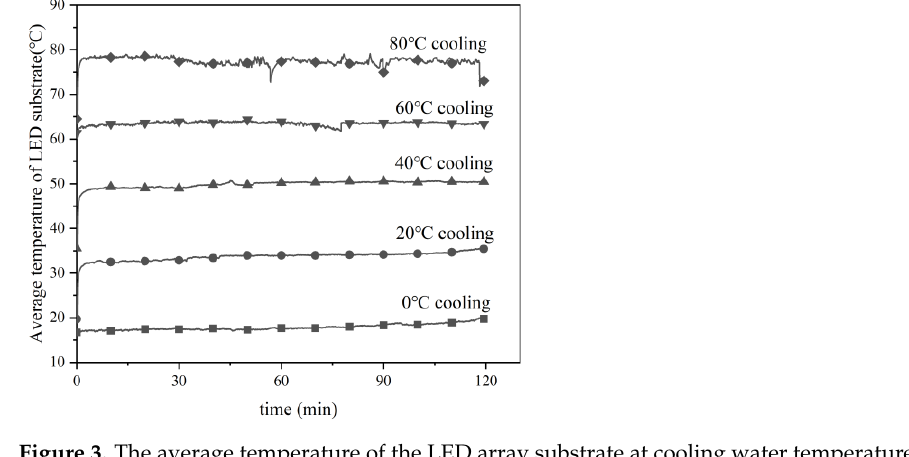
Figure 3. The average temperature of the LED array substrate at cooling water temperatures of 0, 20, 40, 60, and 80 °C.